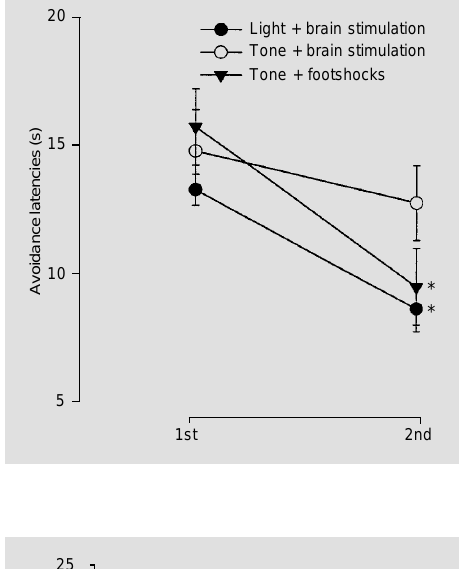
Figure 3 - Number of avoidance responses during the first and second segments of two-way active avoidance sessions for rats submitted to conditioning by pairing light or a tone with brain stimulation and a tone with footshock. Each session con- sisted of 50 trials. The results were pooled and divided into two halves for analysis. Data are reported as mean ± SEM for N = 8 rats in each group. *P<0.05 compared to 1st segment (Newman-Keuls